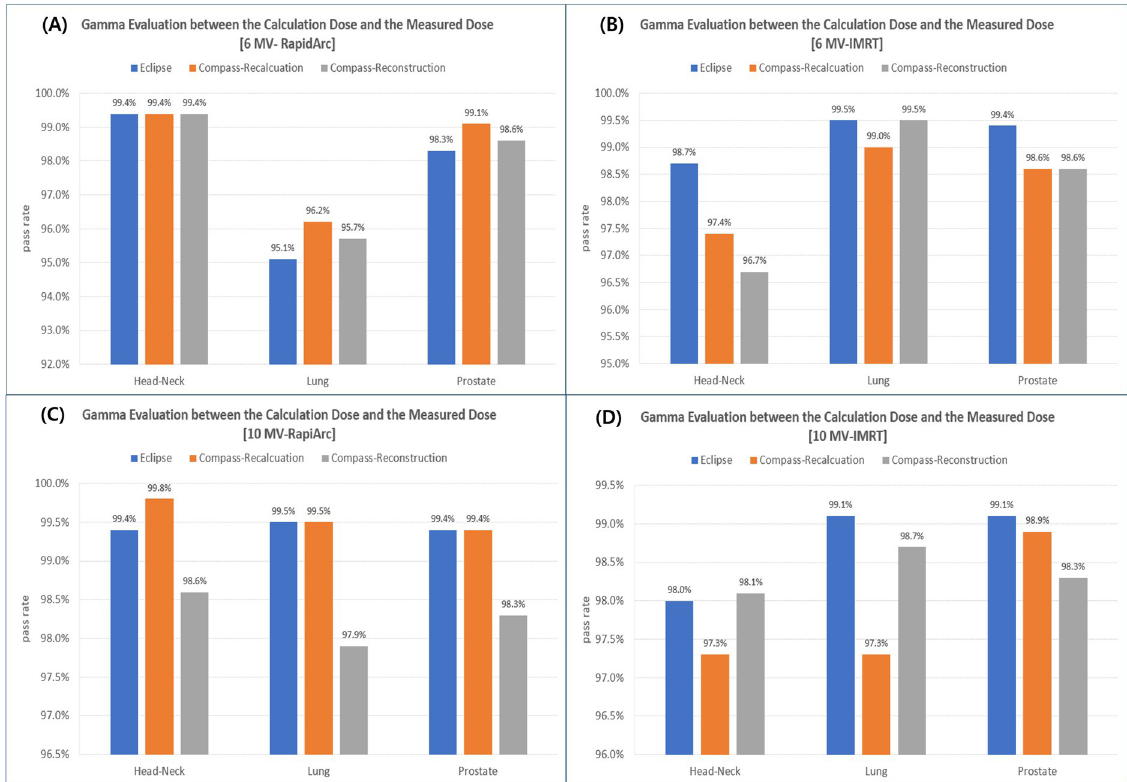
Fig 6. Comparison of the pass rate calculated in a gamma evaluation between a measured dose using ArcCHECK and a predicted dose for each dose calculation tool. (A) 6 MV-RapidArc plans, (B) 6 MV-IMRT plans, (C) 10 MV-RapidArc plans, (D) 10 MV-IMRT plans.